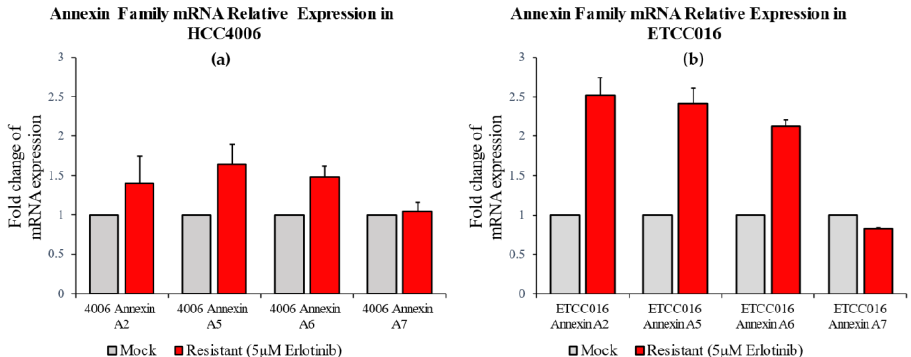
Figure 2. MTS assay of HCC4006 and HCC4006R cell lines. The drug resistance (HCC4006R) cell line was established by 10 cycles of drug treatment. Compared to drug-sensitive HCC4006M cells, a three orders of magnitude increase in the concentration of erlotinib is required to reduce the viability of HCC4006R cell line to 50%.